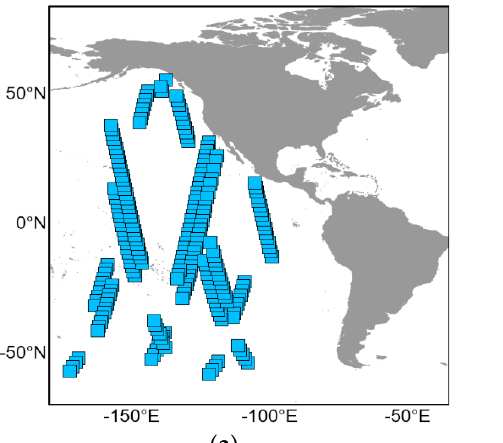
Figure 2. Flowchart of wave joint inversion method for SAR and wave spectrometer.